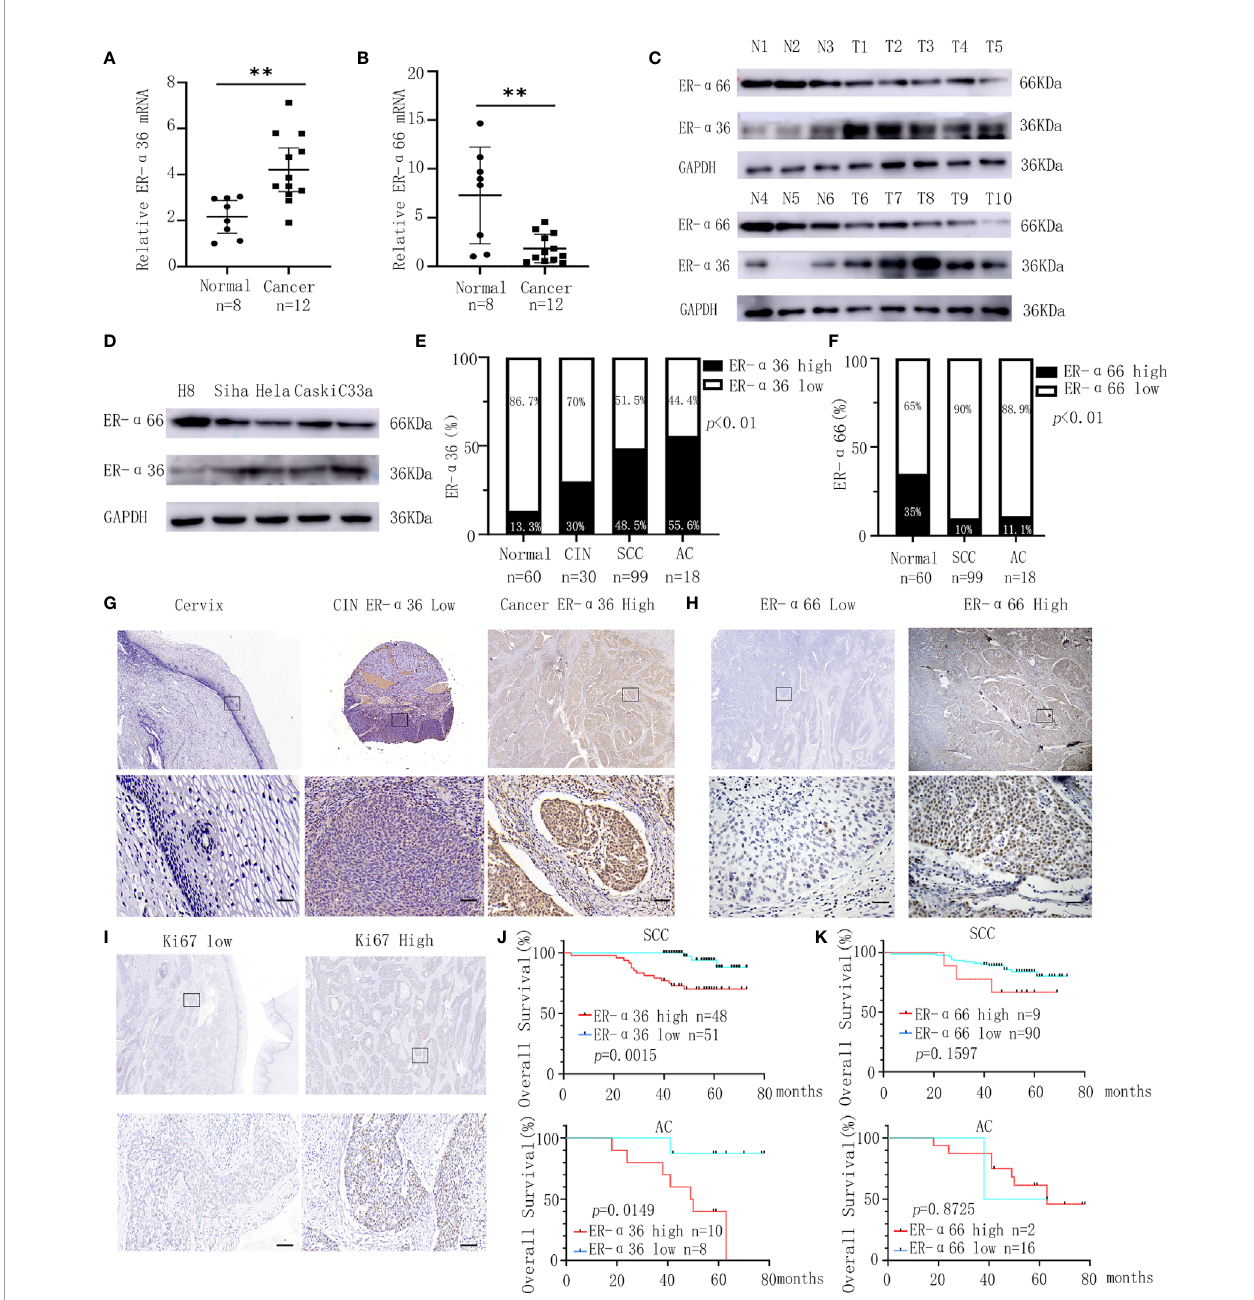
FIGURE 1 | Expression and prognostic signi fi cance of ER- a 36 and ER- a 66 in CC. (A, B) The mRNA levels of ER- a 36 and ER- a 66 in CC tissues and normal cervical tissues. (C) The protein levels of ER- a 36 and ER- a 66 in CC tissues (T1-T10) and normal cervical tissues(N1-N6). (D) The protein levels of ER- a 36 and ER- a 66 in H8, siha, hela, caski and C33a cell lines. (E) The high and low expression rate of ER- a 36 in 60 cervical tissues, 30 CIN tissues, 99 cervical SCC tissues and 18 cervical AC tissues. (F) The high and low expression rate of ER- a 66 in 60 cervical tissues, 99 cervical SCC tissues and 18 cervical AC tissues. (G) Representative images of IHC staining of ER- a 36 in CC tissues, CIN and cervical tissues (upper, ×40; lower, ×400, Scale bar: 50 m m). (H, I) Representative images of IHC staining of ER- a 66 and Ki67 in CC tissues (upper, ×40; lower, ×400, Scale bar: 50 m m). (J) High expression of ER- a 36 was signi fi cantly correlated with low overall survival rate in cervical SCC and cervical AC. (K) The expression of ER- a 66 displayed no prognostic signi fi cance in cervical SCC and cervical AC. (**p <